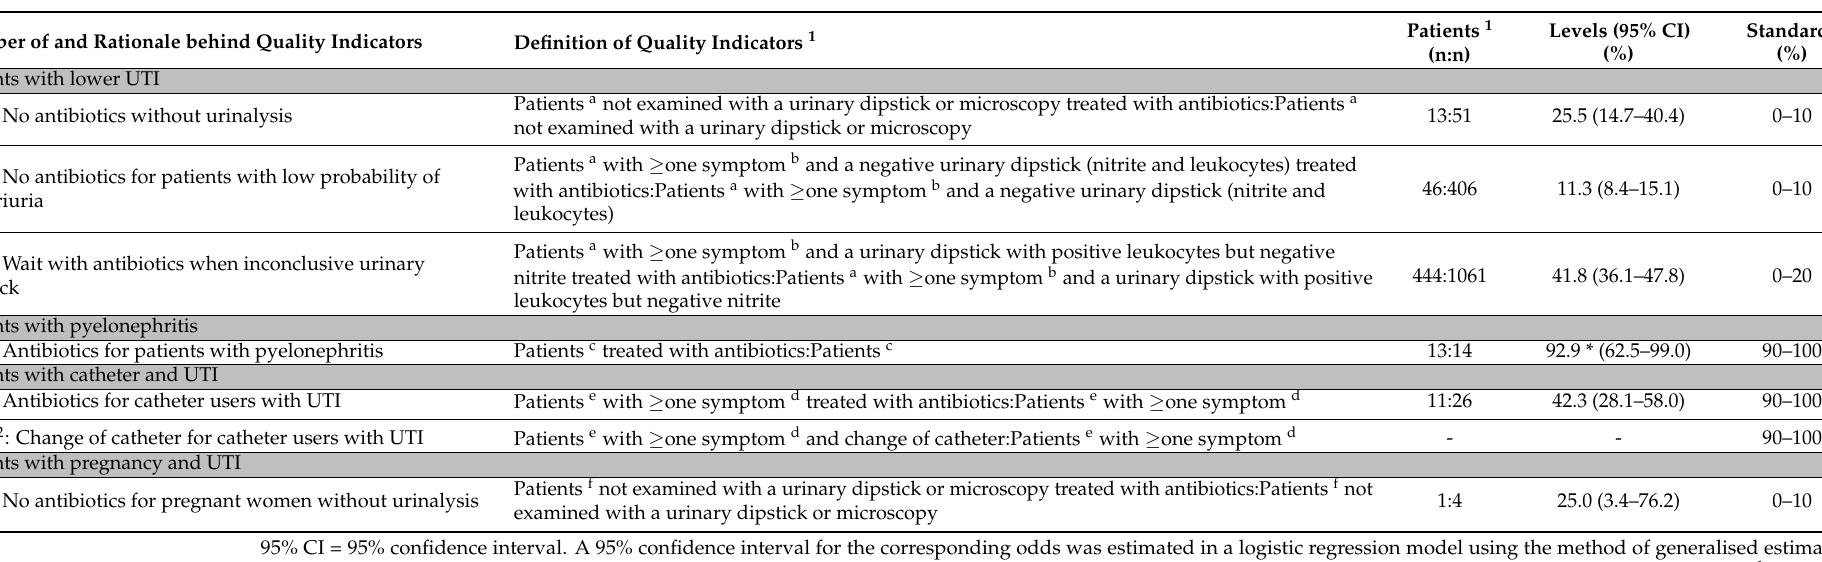
Table 2. Levels and standards for seven quality indicators focusing on the treatment decision for urinary tract infections in Danish general practice (2020). Number of and Rationale behind Quality